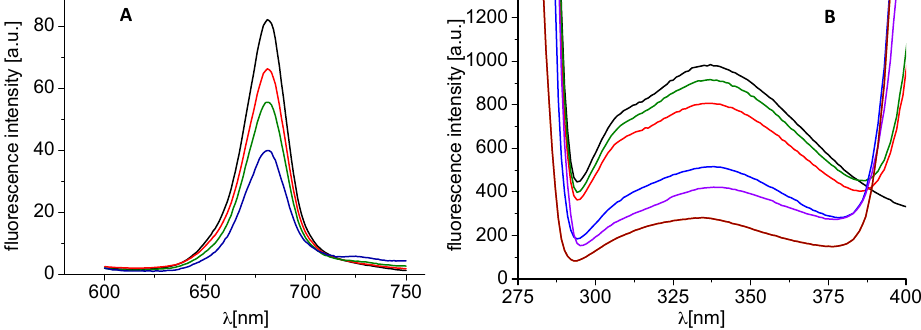
Figure 2. Fluorescence emission spectra of chlorophyll a in untreated spinach chloroplasts in presence of compound 23 (R = 5-Br-2-Cl; c = 0, 56, 220, and 431 µM; curves from top to bottom); excitation wave length λ ex = 436 nm, chlorophyll concentration 10 mg/L ( A ) and fluorescence emission spectra of aromatic amino acids in suspension of spinach chloroplasts without and with compound 23 (c = 0, 5.9, 11.8, 23.6, 29.5 and 47.2 µM; curves from top to bottom); excitation wave length λ = 275 nm, chlorophyll concentration 10 mg/L ( B ).